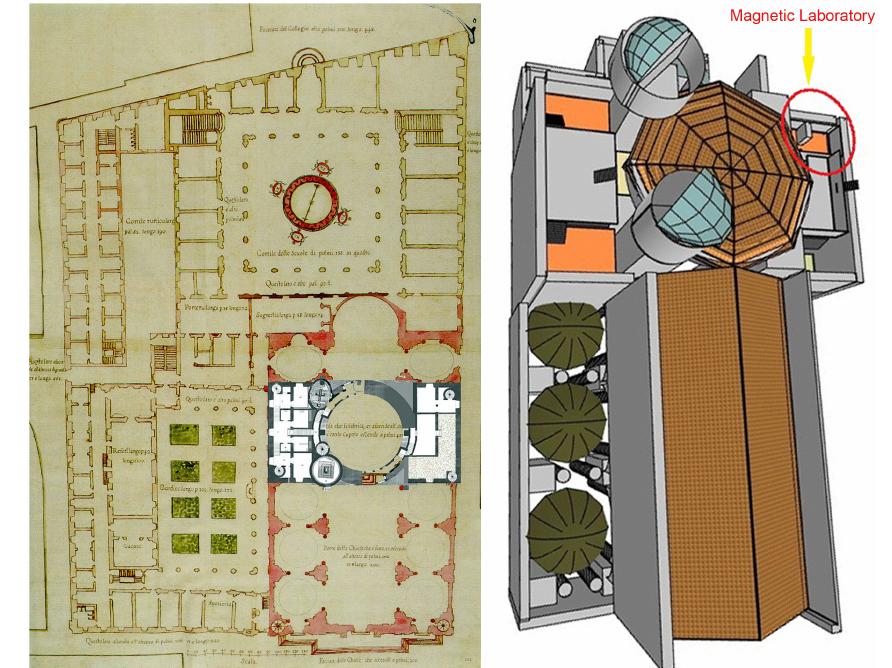
Figure 5. Farther Secchi’s astronomical and magnetic observatories on the roof of the church of Sant’Ignazio. Left: map of the Collegio Romano building and the church of Sant’Ignazio (Archivio Storico S. J., Rome). The church map is red and the position of the observatories is highlighted in white. Right: a 3-D picture of the observatories on the church roof. The yellow arrow points to the magnetic observatory, indicated by a red circle. Courtesy of R.